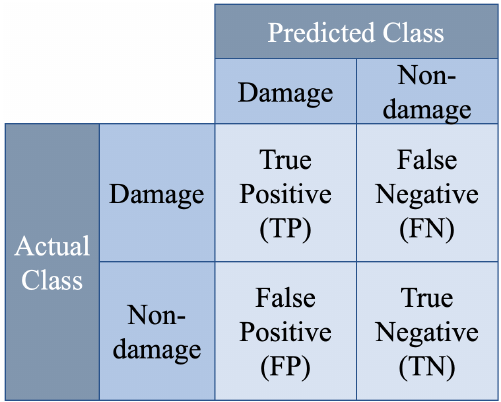
Figure 9. Confusing Matrix of